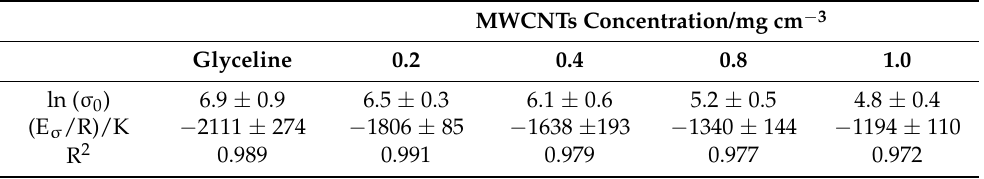
Figure 8. Plot of the logarithm of the conductivity against the reciprocal value of the absolute temperature (1/T) for glyceline ( a ) and water ( b ) containing MWCNTs with different concentrations. Tables 9 and 10 lists the values of ln ( σ 0 ) (interception), E σ /R (slope), and the regression coefficient (R 2 ) the model for conductivity/temperature in glyceline and water, respectively. The minimum R 2 was 0.972, for the higher concentrations of MWCNTs in glyceline. Table 9. Conductivity–temperature model parameters for MWCNTs dispersed in glyceline.